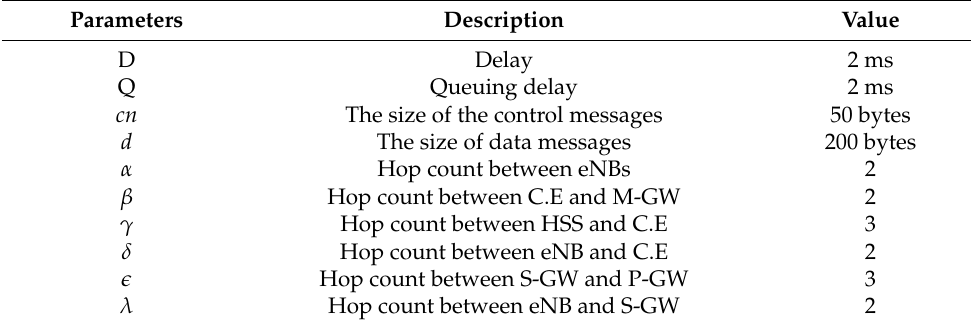
Table 1. Default values are used in the numerical